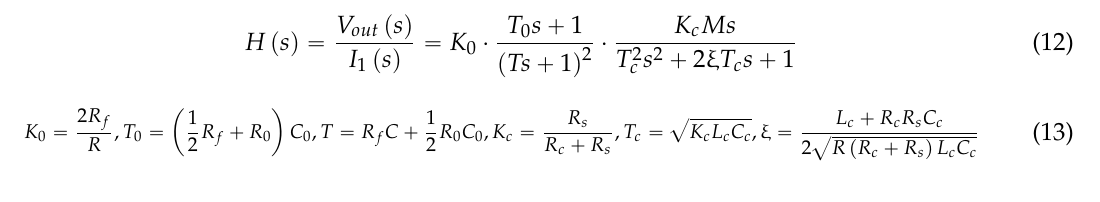
Figure 10. The frequency response of the proposed sensor.